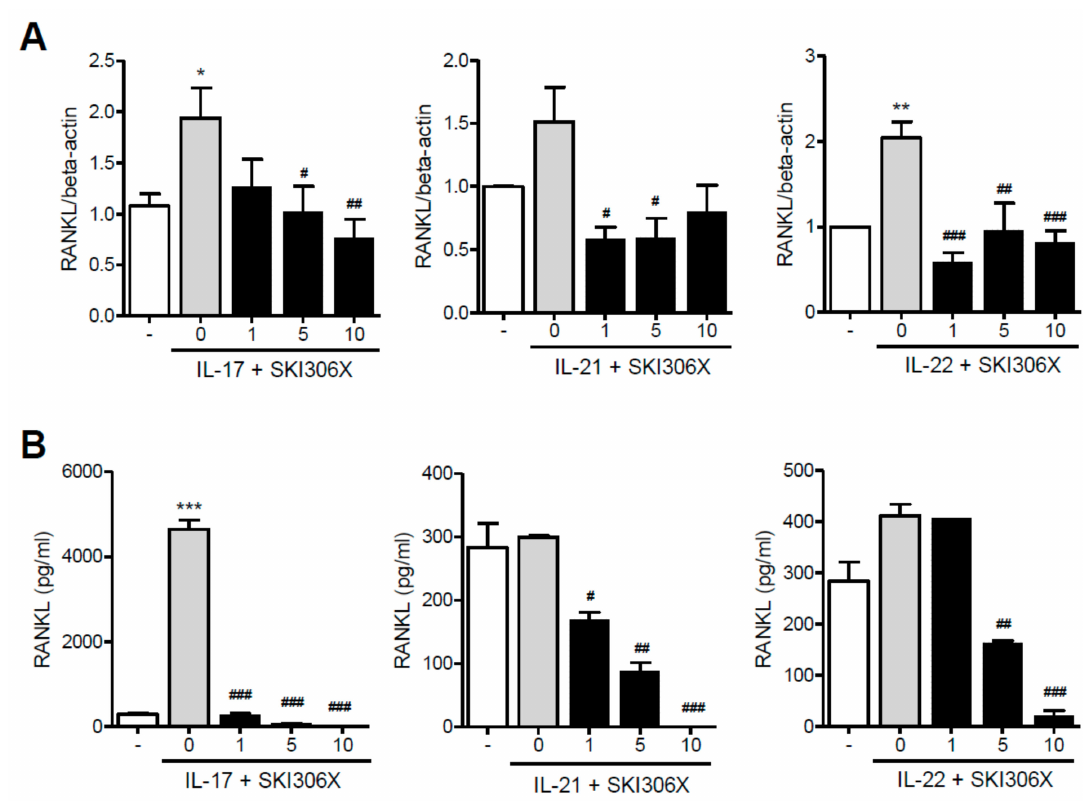
Figure 3. The inhibitory e ff ect of SKI306X in Th17 cytokine-induced receptor activator of nuclear factor kappa-B ligand (RANKL) expression and production in synovial fibroblasts in RA. ( A ) RA synovial fibroblasts were cultured in medium supplemented with IL-17, IL-21, and IL-22 with various concentrations of SKI306X, and RANKL expression was examined using real-time PCR, normalized to beta-actin and reported in relative expression units. ( B ) RA synovial fibroblasts were cultured in medium supplemented with IL-17, IL-21, and IL-22 with various concentrations of SKI306X, and RANKL production in the culture media was examined using ELISA. The data represent mean ± SD values from six independent experiments. * p < 0.05, ** p < 0.01 and *** p < 0.001 compared with the nil condition (white bars). # p < 0.05, ## p < 0.01 and ### p < 0.001 compared with the Th17 cytokine stimulating condition (gray